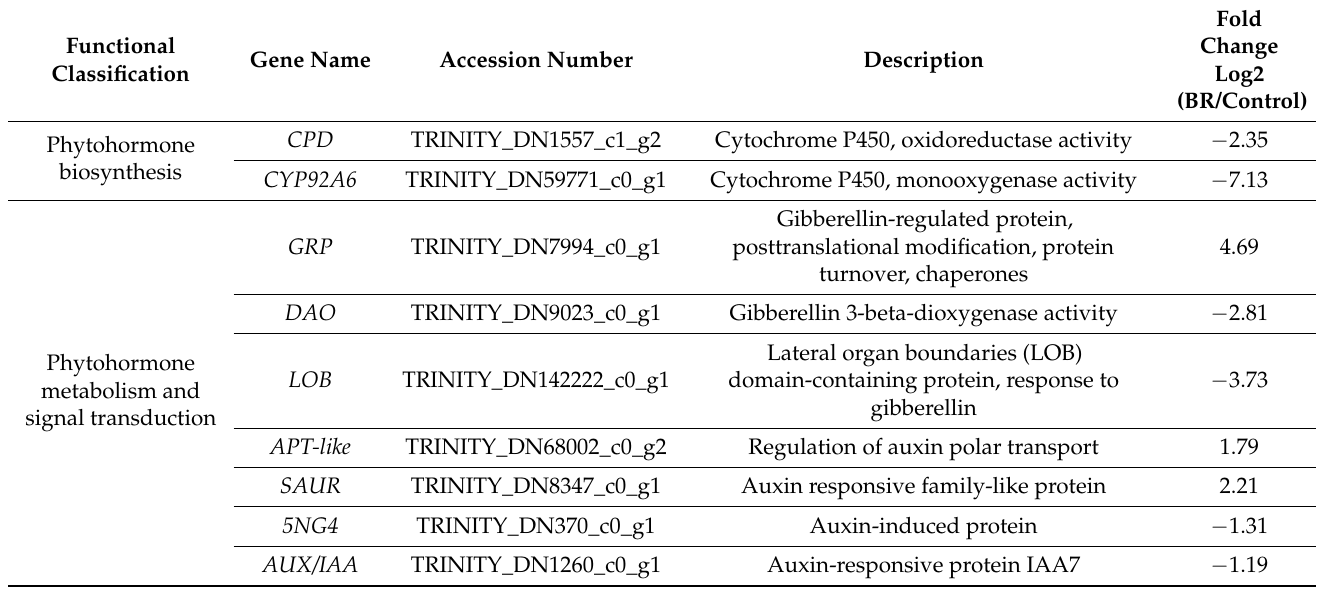
Table 1. Important genes in biosynthesis, metabolism and signal transduction of endogenous hormones.